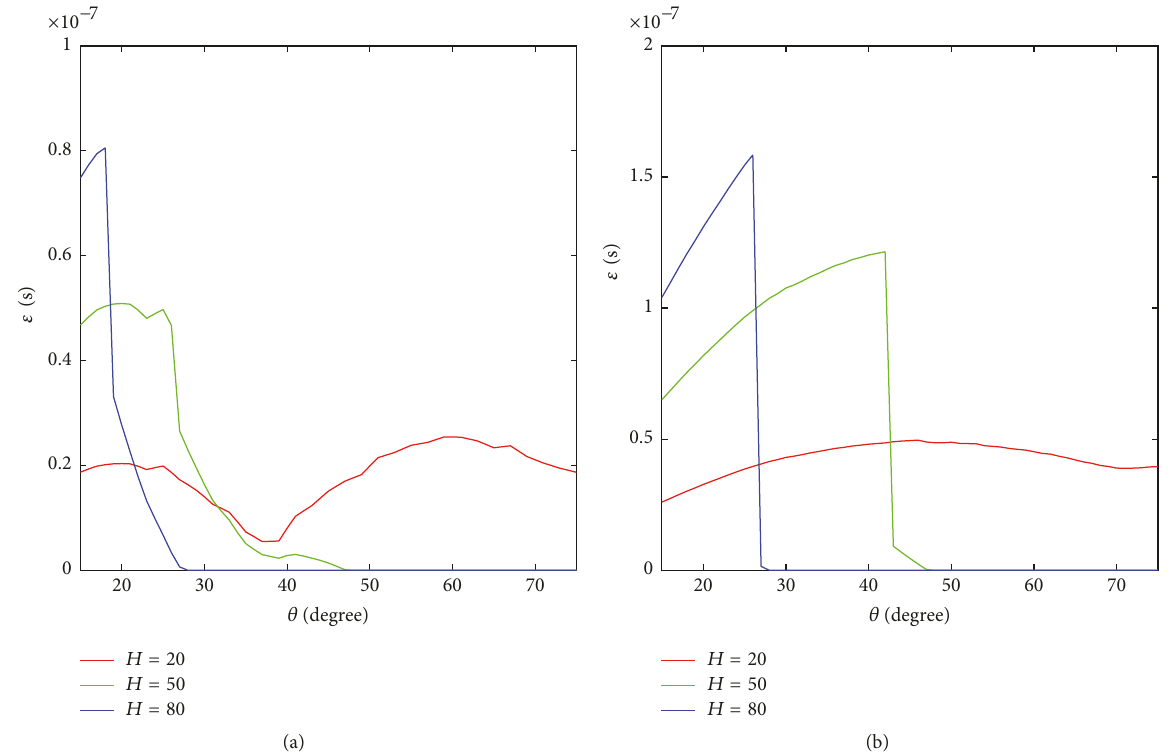
Figure 9: This figure shows the variety of the PPE with the satellite elevation angle 𝜃 . In this figure, the width 𝑇 𝑐 of chip is set to 1/1.023𝑒6 as the C/A code in GPS; the interval of correlators is 𝑑 = 0.25𝑇 𝑐 . (a) is the result of antenna Ashtech. (b) is result of antenna